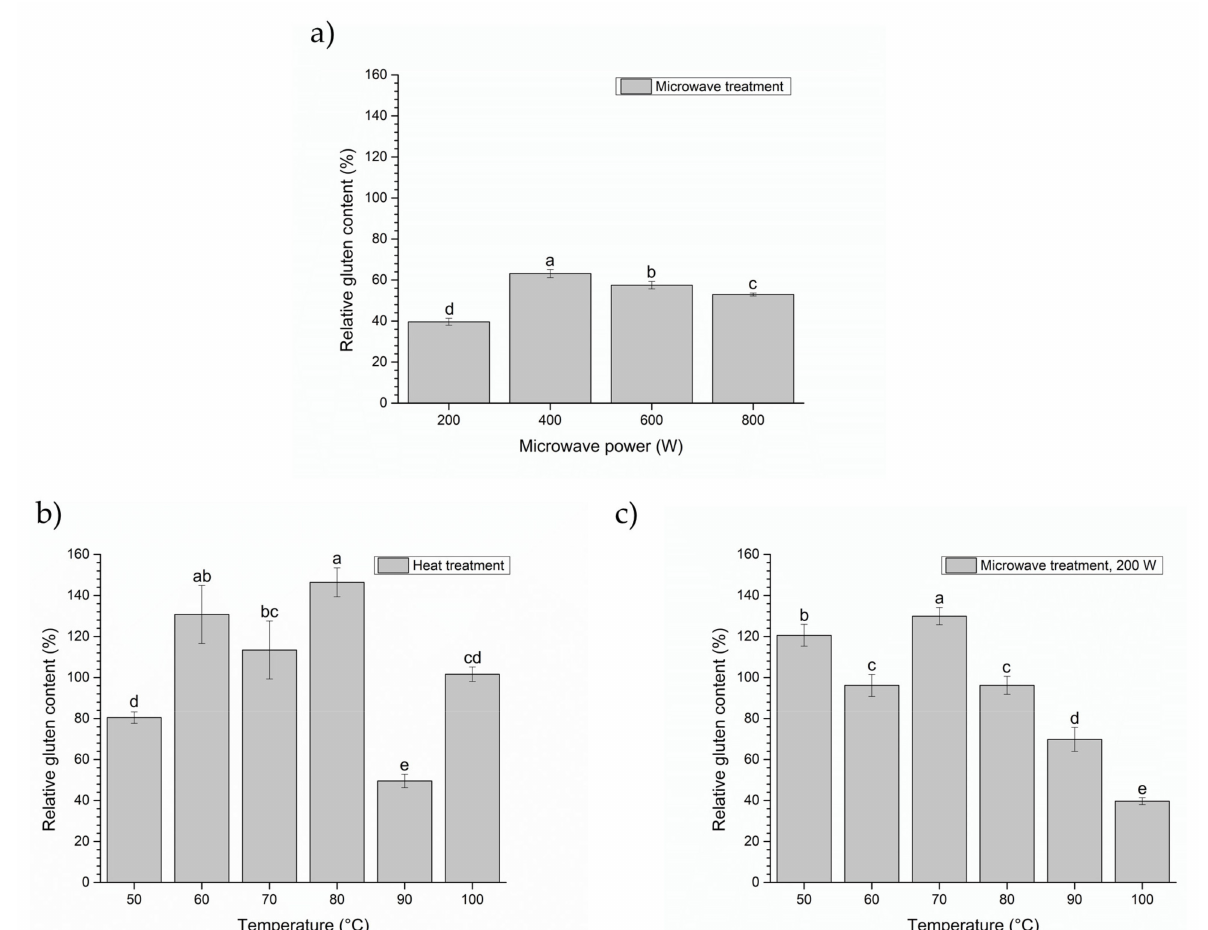
Figure 1. Relative gluten content (%) detected after ( a ) microwave treatment of wheat gluten at different microwave powers (200–800 W); ( b ) heat treatment of wheat gluten at different temperatures (50–100 ◦ C); and ( c ) microwave treatment of wheat gluten at 200 W at different controlled temperatures (50–100 ◦ C). All measurements were compared to an untreated gluten sample, considered as control (100%). Results are expressed as mean ± standard deviation ( n = 2). Means with different letters in the same figure are significantly different ( p <